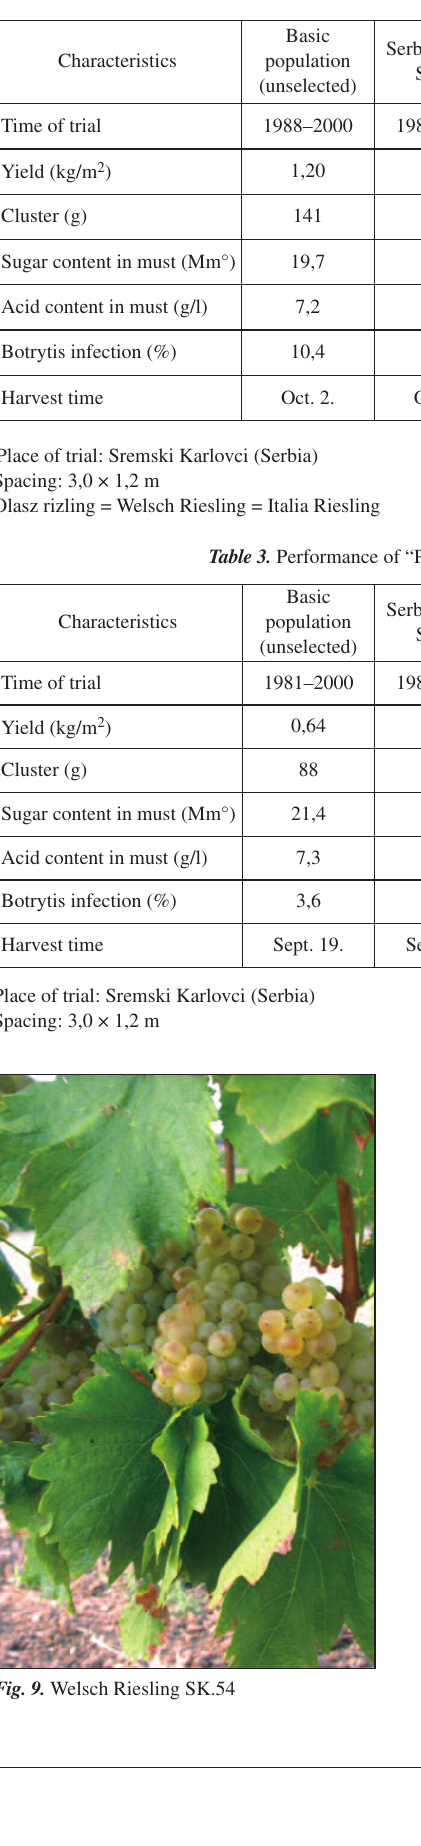
Table 2. Performance of “Olasz rizling” clones